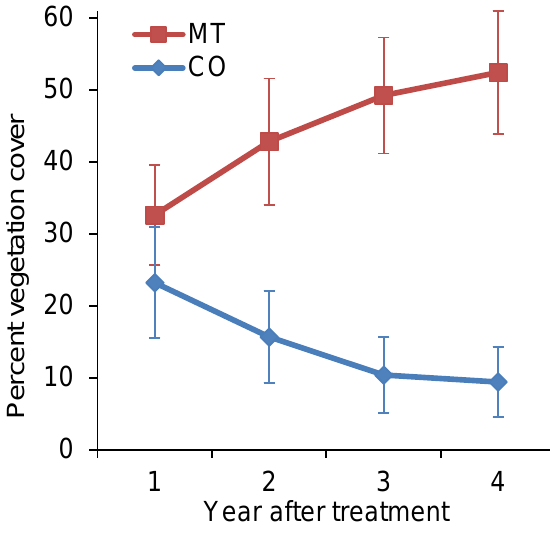
Figure 1. The mean percent vegetation cover in the four years following treatment at the plots at Meall nan Tarmachan (MT) n = 15 and Coire Odhar (CO) n = 15. Error bars are ± 1 standard error